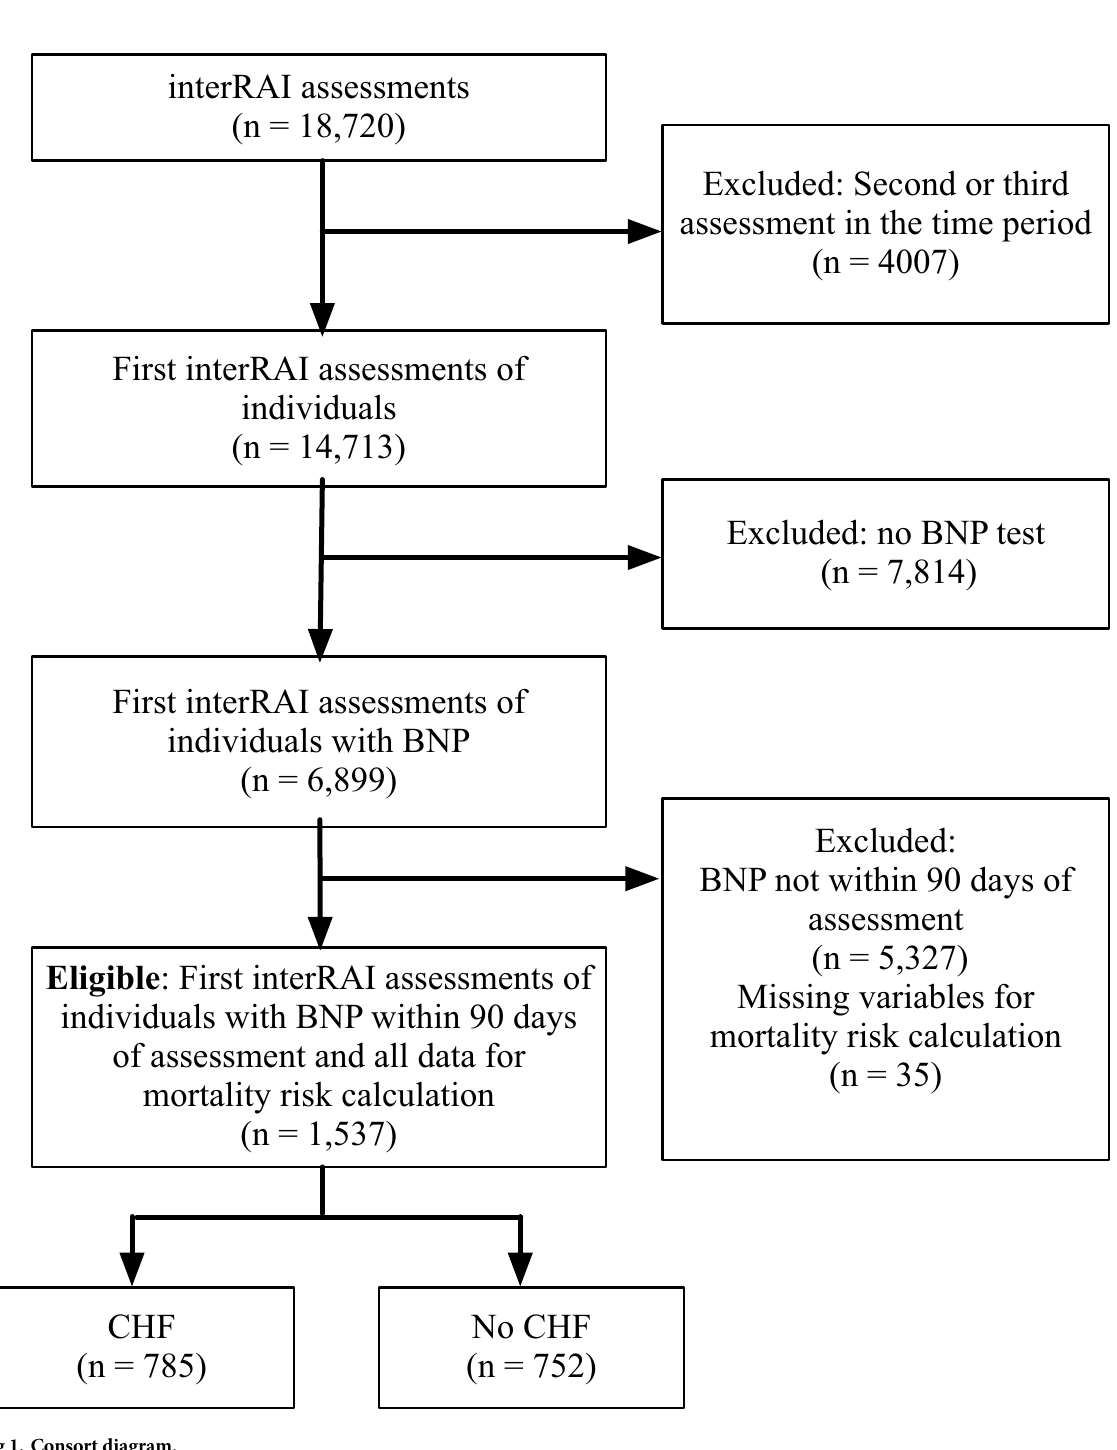
above about 0.3. The decision curve shows that the addition of BNP improves the application of the risk model amongst those with baseline risk up to 0.75, (Fig 4C). The new model remained well calibrated overall in each of the CHF and no CHF cohorts, (Fig 5).